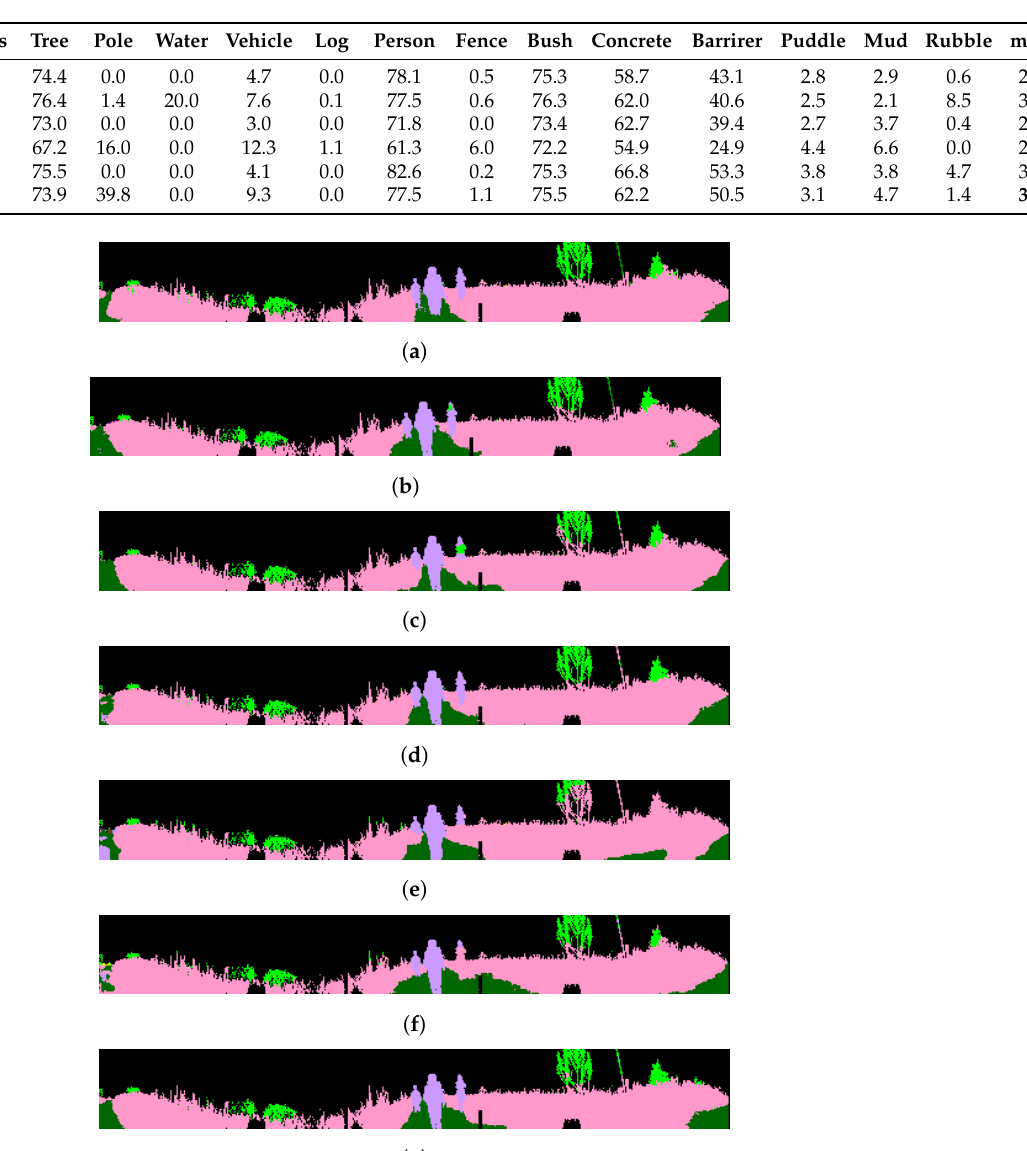
Table 8. Evaluation results on the RELLIS-3D dataset. The values are in %. The highest mIoU value is shown as bold.